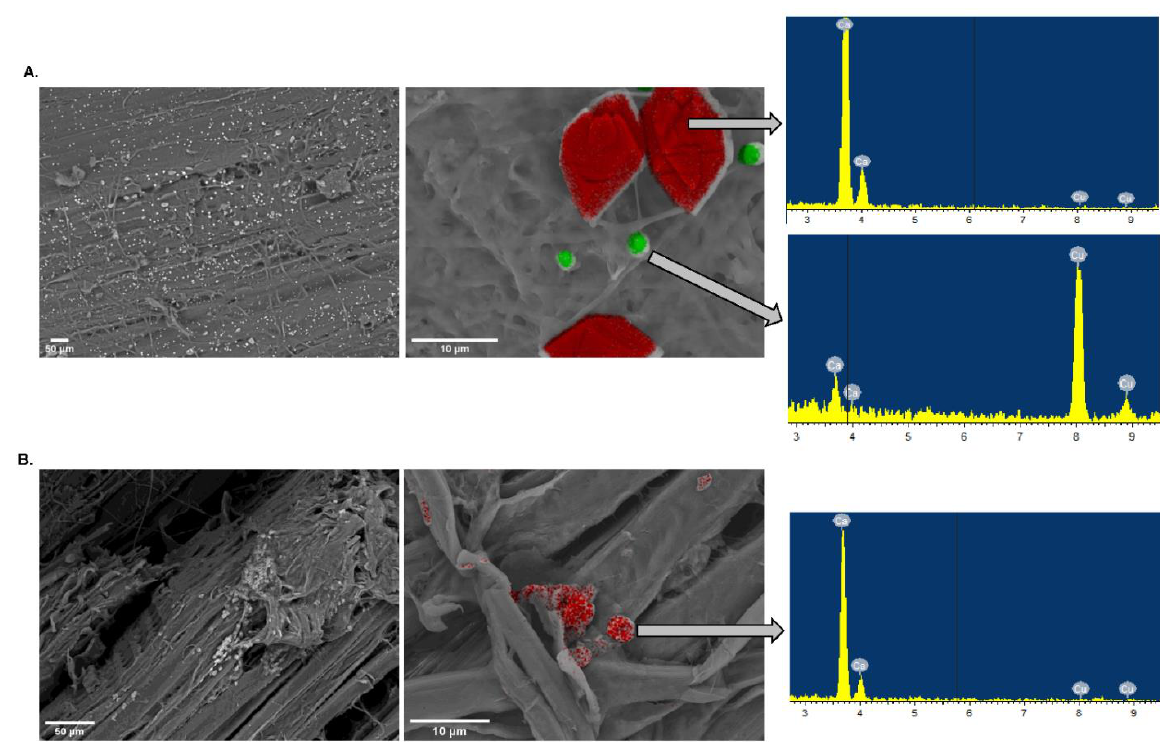
Figure 5. SEM images of oxalate crystals after 10-day culture of P. chrysosporium and R. placenta with TSD. ( A ) Oxalate crystals produced by R. placenta . Red crystals (diamond shape) and green crystals (ball shape) represent calcium and copper oxalate crystals, respectively. ( B ) Oxalate crystals produced by P. chrysosporium . Only calcium oxalate crystals were detected.